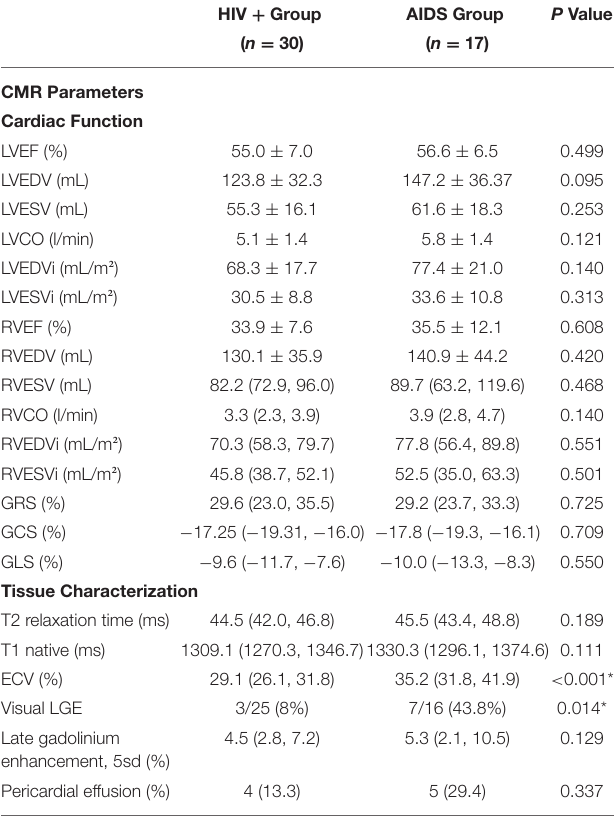
TABLE 2 | CMR characteristics of HIV